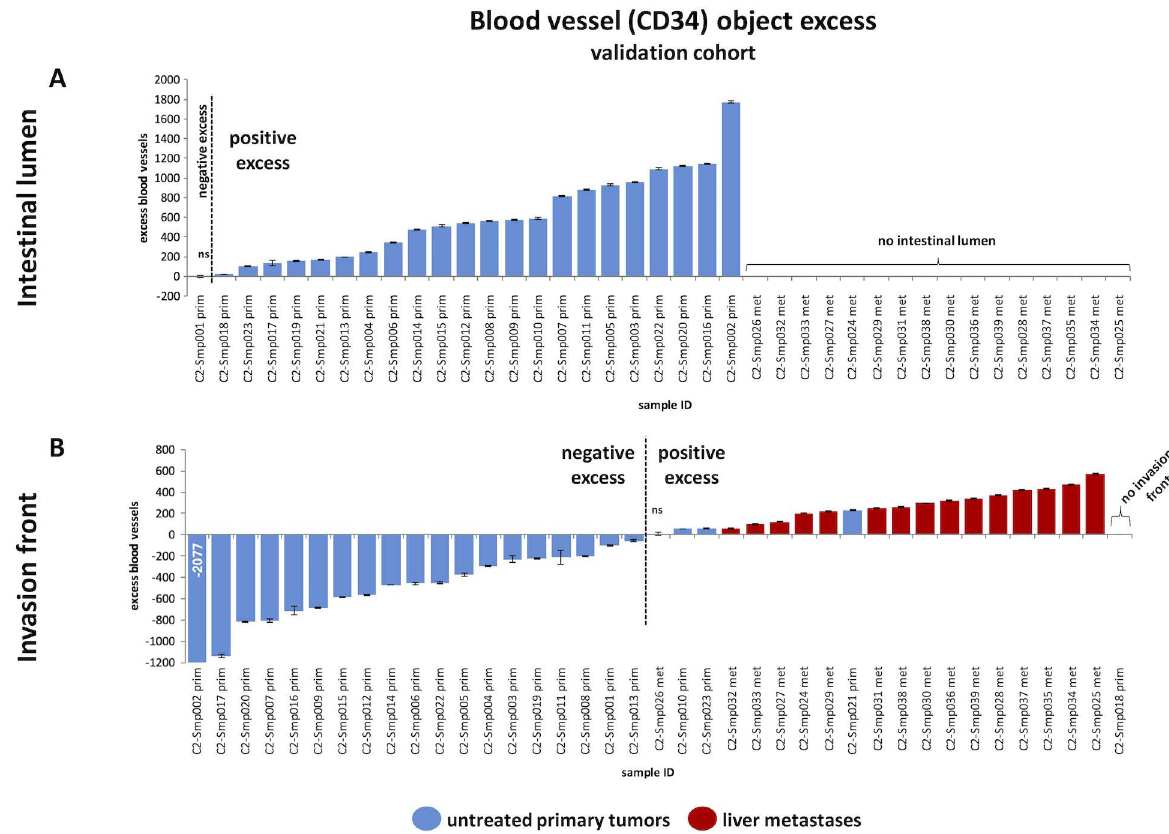
Fig 6. Magnitude of angiogenic zones for all analyzed samples in the validation cohort, shown as waterfall plots. This Fig shows the result of the analysisof the independent validationcohort of N = 39 samples and is organizedidenticallyto Fig 5 . (A) Analysis of blood vessel aggregationin the tumor parts next to the intestinallumen. (B) Blood vessel excess at the invasionfront. The first sample was croppedat -1200, but the true value of -2077 is overlaidon the bar. (A-B) Error bars indicatethe 95% confidenceinterval that was calculatedby a Monte Carlo method. All measurements are statisticallysignificant except if labeled“ns” (for “not